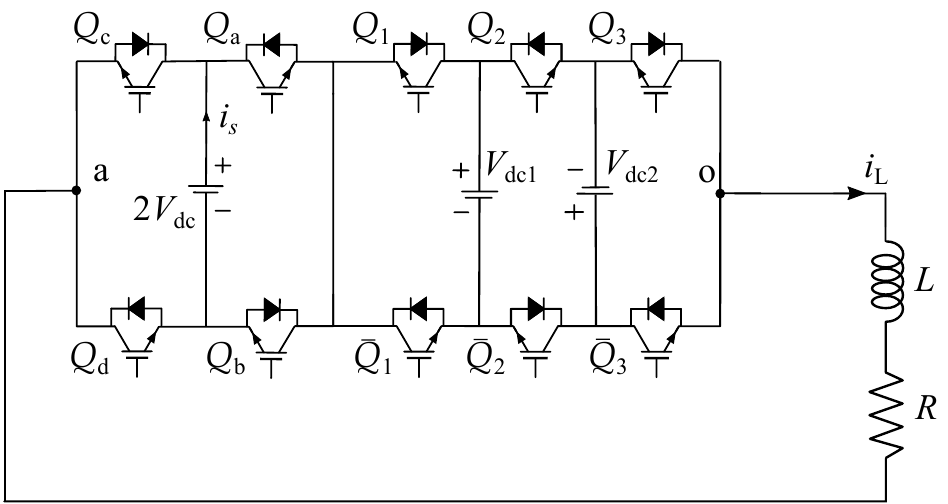
Figure 1. HMLI topology connected to RL load. Table 1. Switching States of HMLI topology connected to RL